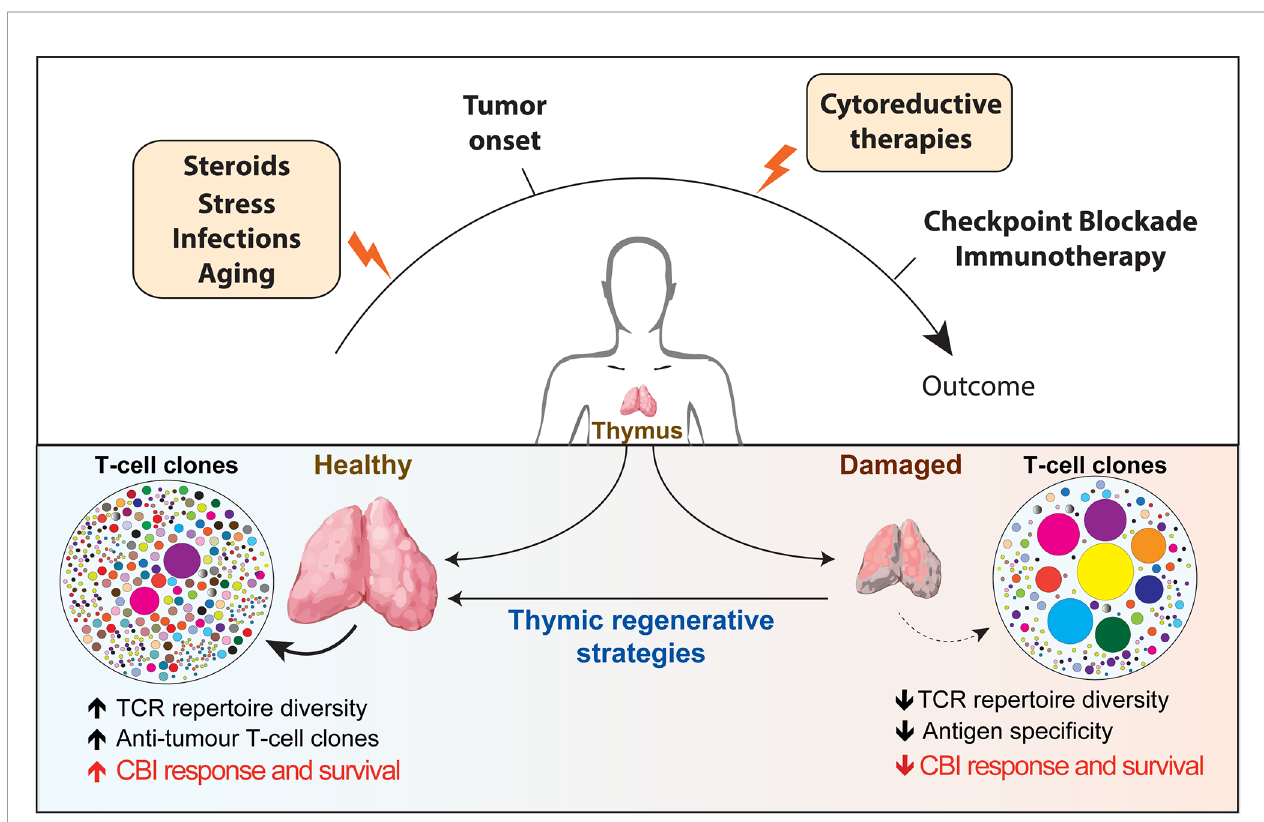
FIGURE 1 | Overview of the factors affecting thymic function and their potential role in regulating patients ’ response to checkpoint blockade immunotherapy. Thymus is particularly sensitive to negative insults that can come from infections, stress, cytoreductive therapies and the physiological process of aging (yellow boxes). The reduction in thymic functionality and in the TCR diversity impaired immune surveillance and may provide a supportive environment for tumors to elude T-cell-mediated response. Instead, a broader TCR repertoire in patients receiving CBI would increase the chance of tumor antigen recognition and favorable long- term clinical outcome. The use of regenerative factors aimed to boost thymic function could improve TCR repertoire diversity and have the potential to signi fi cantly extend the clinical ef fi cacy of CBI. TCR, T cell repertoire; CBI, checkpoint blockade immunotherapy; SSA, sex steroids